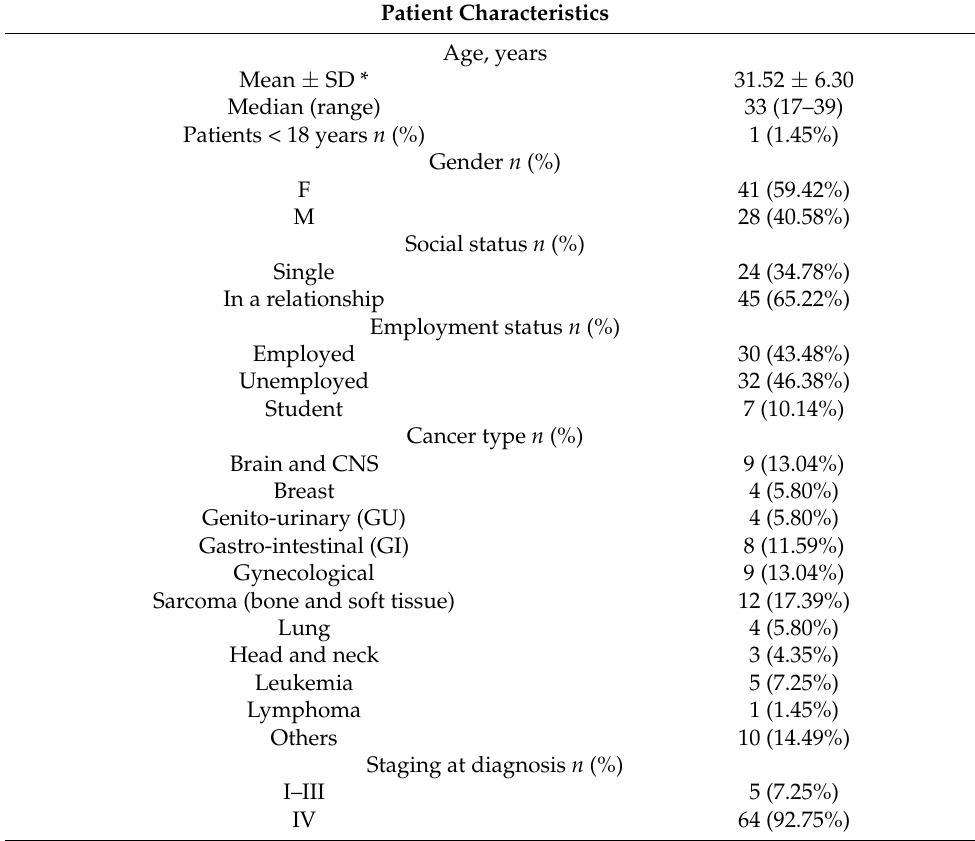
Table 1. Patient demographics ( n =